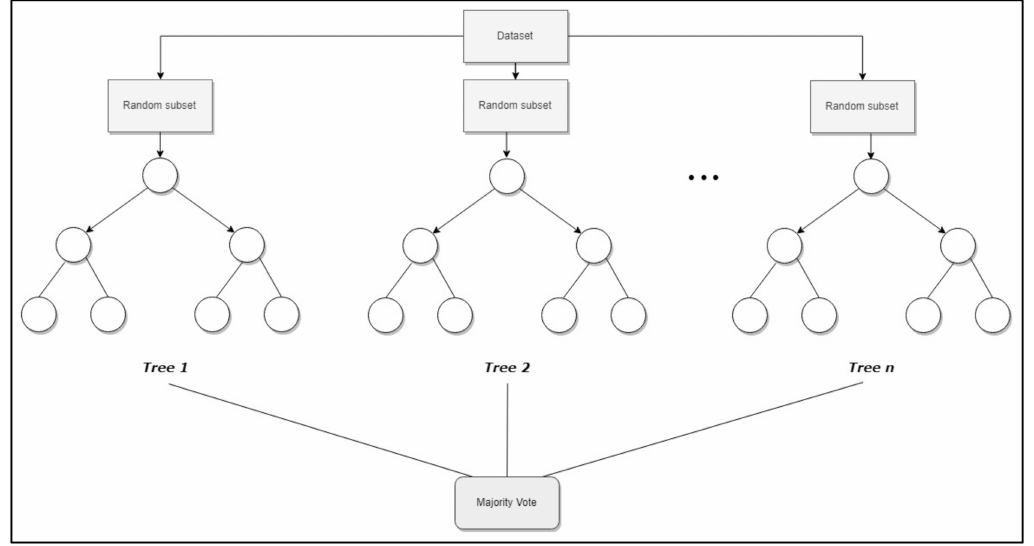
Figure 2. Topology of Random